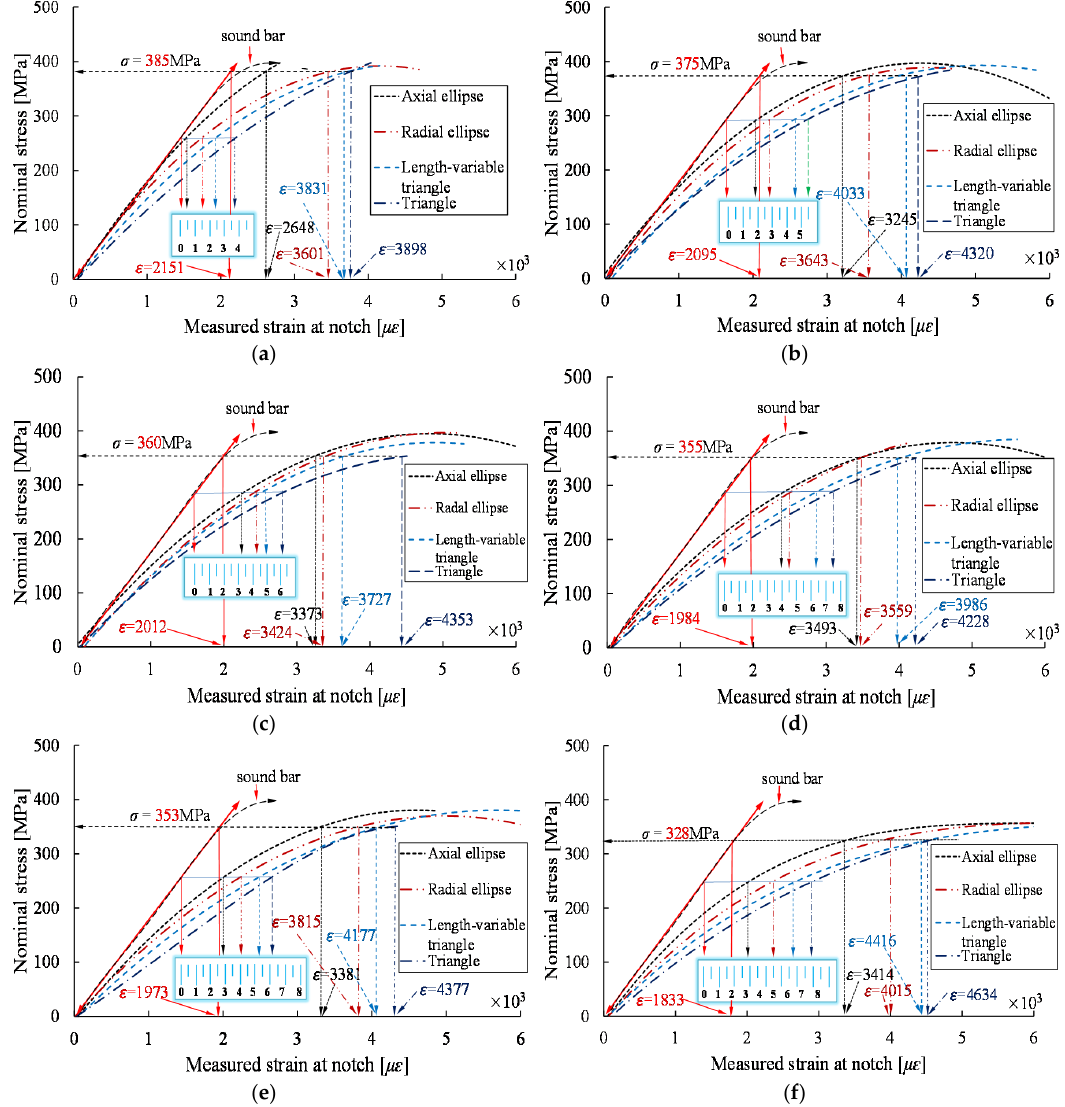
Figure 5. Stress-strain curves of samples with the same depths. ( a ) d = 1.5 mm; ( b ) d = 1.7 mm; ( c ) d = 1.9 mm; ( d ) d = 2.1 mm; ( e ) d = 2.3 mm; ( f ) d = 2.5 mm. ( c ) d = 1.9 mm; ( d ) d = 2.1 mm; ( e ) d = 2.3 mm; ( f ) d = 2.5